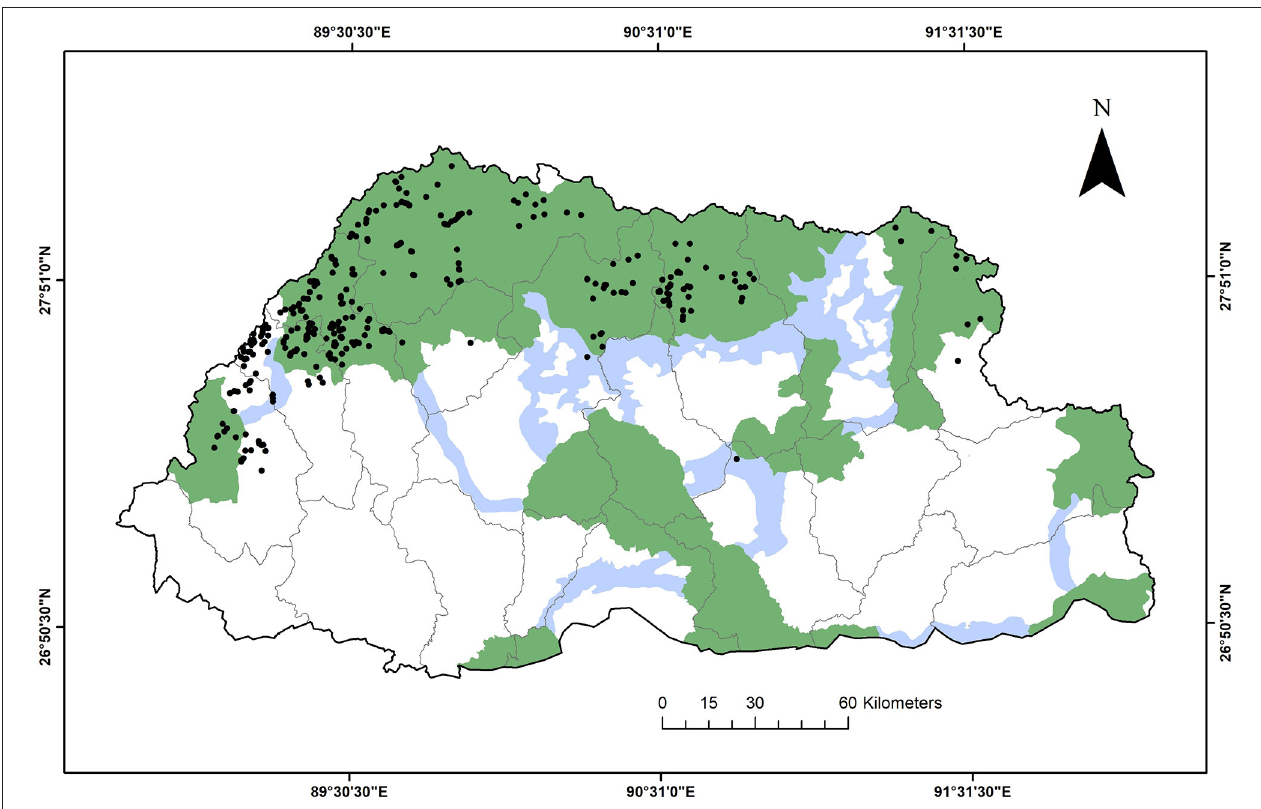
FIGURE 2 | Snow leopard occurrence records (black dots) in Bhutan, overlaid on protected areas (green), biological corridors (blue), and dzongkhags (districts, black outlines).